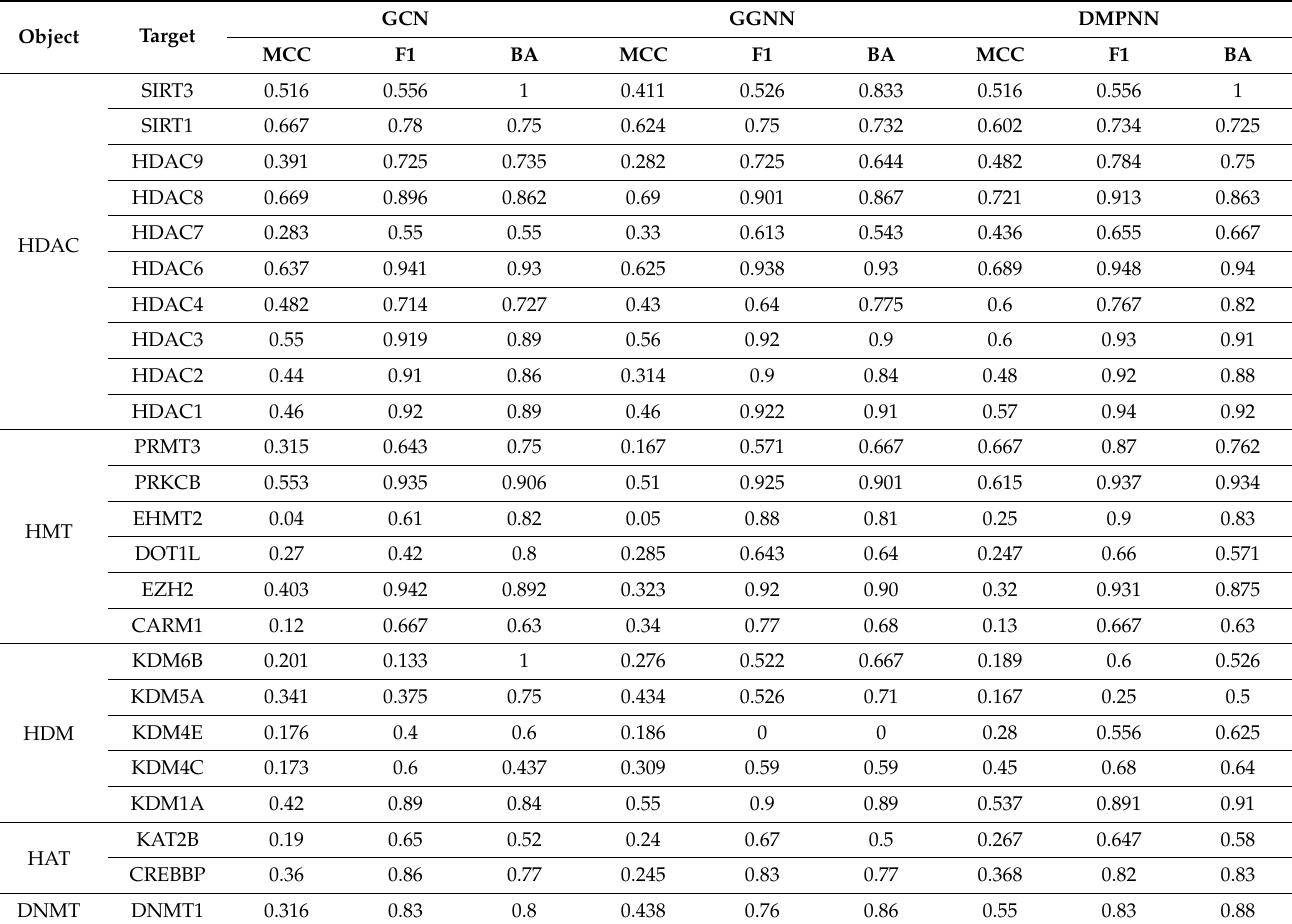
Table 1. Single-target performance comparison of three GNNs. The supervised learning algorithm was XGBoost. Three performance metrics: MCC, F1, and BA were adopted for these 24 single-target binary classifiers.